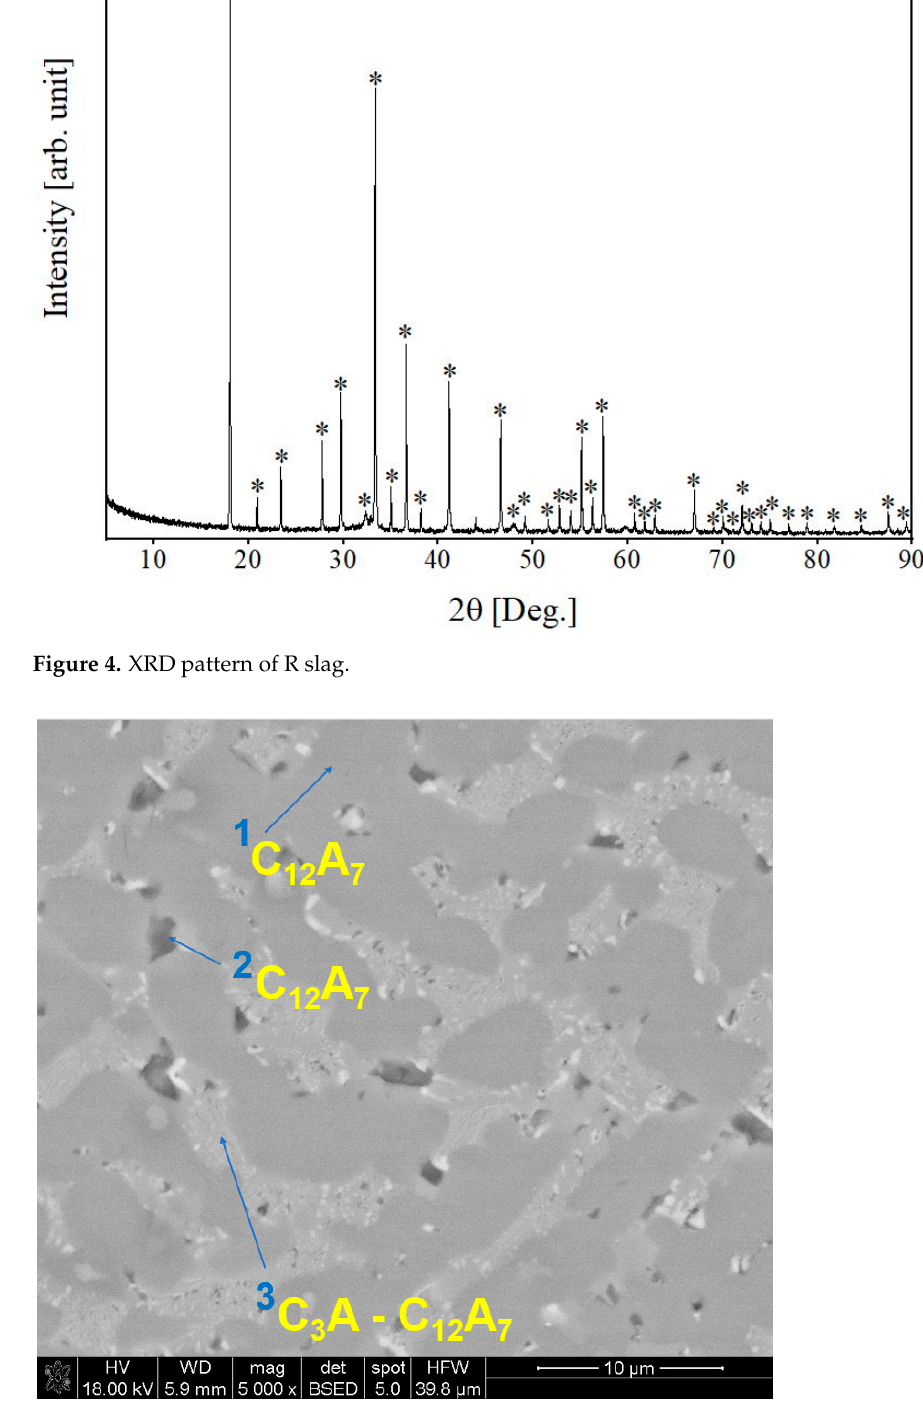
Figure 5. SEM micrograph with EDS in selected micro-areas for reference slag R. Table 4. EDS analysis of micro-areas indicated in Figure 5.